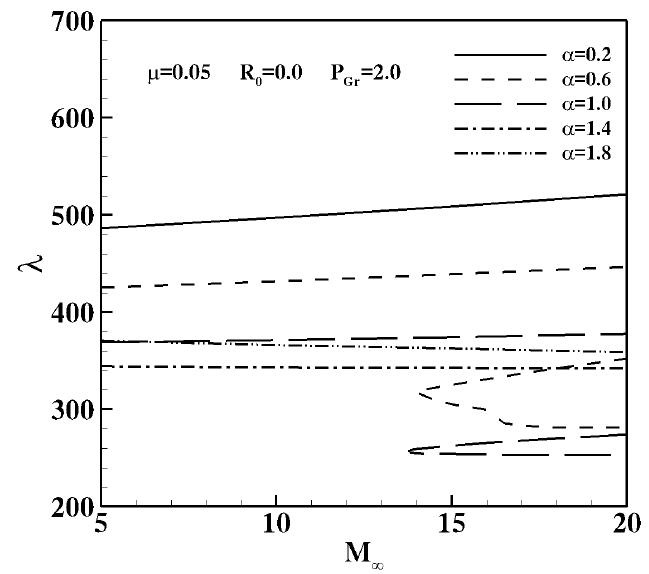
Figure 20. Variation curve of critical dynamic pressure with freestream Mach number for different coefficients of head-panel pressure.